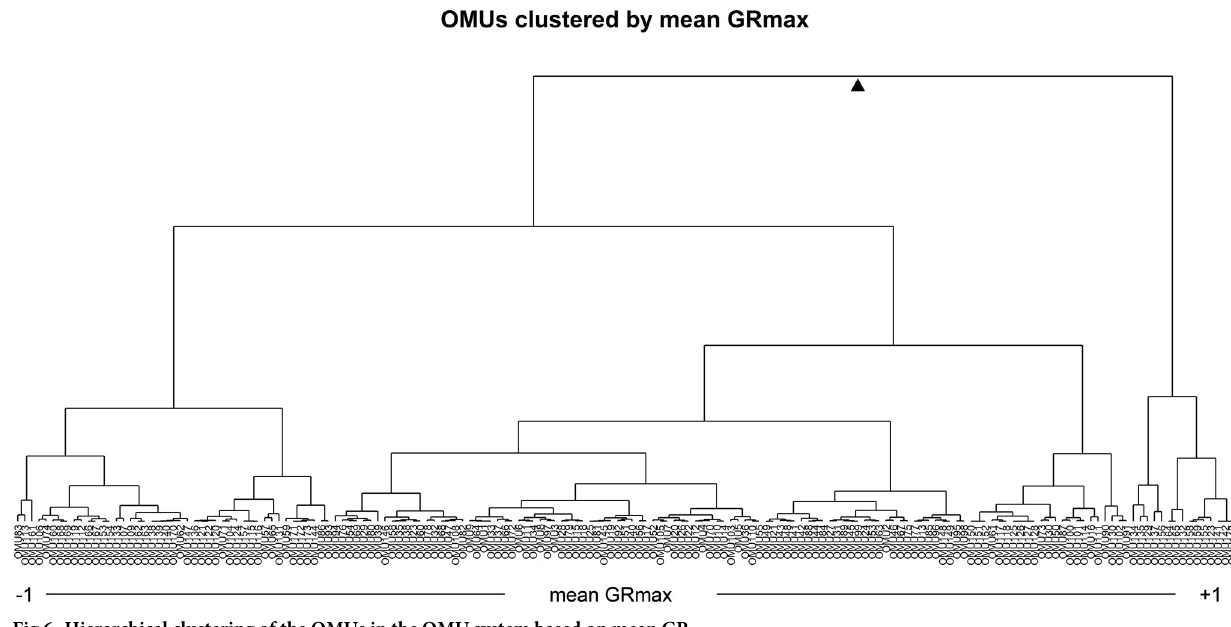
Fig 6. Hierarchical clustering of the OMUs in the OMU system based on mean GR max .